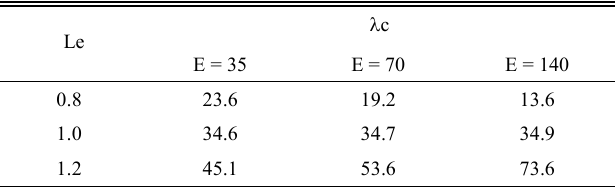
TABLE 1. Critical wavelengths at Le = 0.8, 1.0 and 1.2, and E =35, 70 and 140 in adiabatic flames.